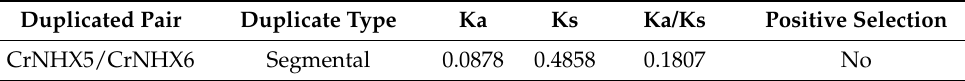
Table 2. Ka/Ks analysis and duplicated type calculation for CrNHX genes. A Ka/Ks ratio<1 indicates purifying selection, a Ka/Ks ratio=1 indicates neutral selection, and a Ka/Ks ratio>1 indicates positive